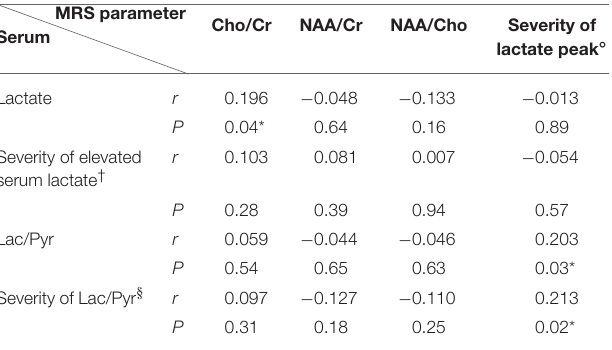
demonstrating stroke-like episodes. These associations are stronger and more obvious during the acute stage than during the chronic stage. However, the importance of the MRS lactate